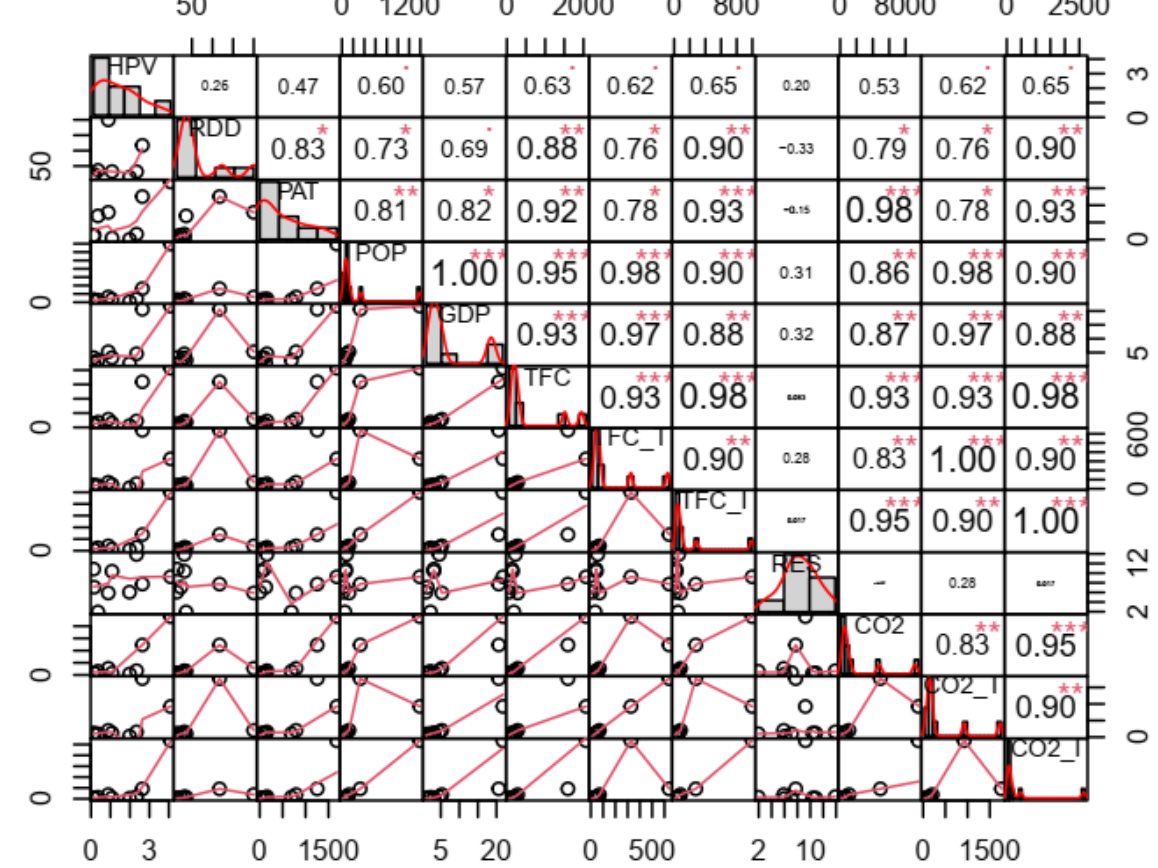
Figure 3. Spearman’s correlation and compilation of data for all analyzed countries in 2018. *, **, ***—the more symbols, the stronger the correlation. Abbreviations: HPV—hydrogen production volume; RDD—energy RD&D in the hydrogen production and fuel cells category; PAT—number of patents; POP—population; GPD—gross domestic product; TFC—total final energy consumption; TFC_T—total final energy consumption in transport; TFC_I—total final energy consumption in industry; RES—share of renewable energy of primary energy supply; CO2—total carbon dioxide emissions; CO2_T—total carbon dioxide emissions in transport; CO2_I—total carbon dioxide emissions in industry.